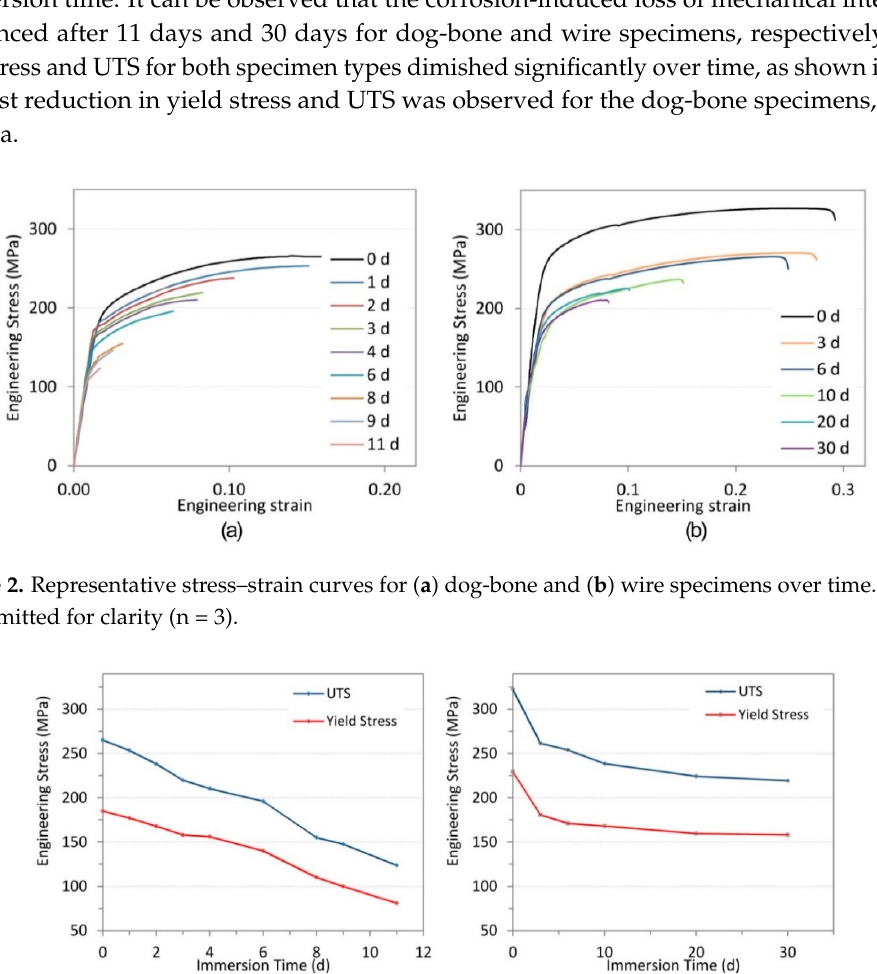
Figure 1. Plot of ( a ) percentage mass lost over time for dog-bone and wire specimens ( b ) evolution of SBF solution pH. Error bars represent 95% confidence intervals derived from T-table (n = 3).